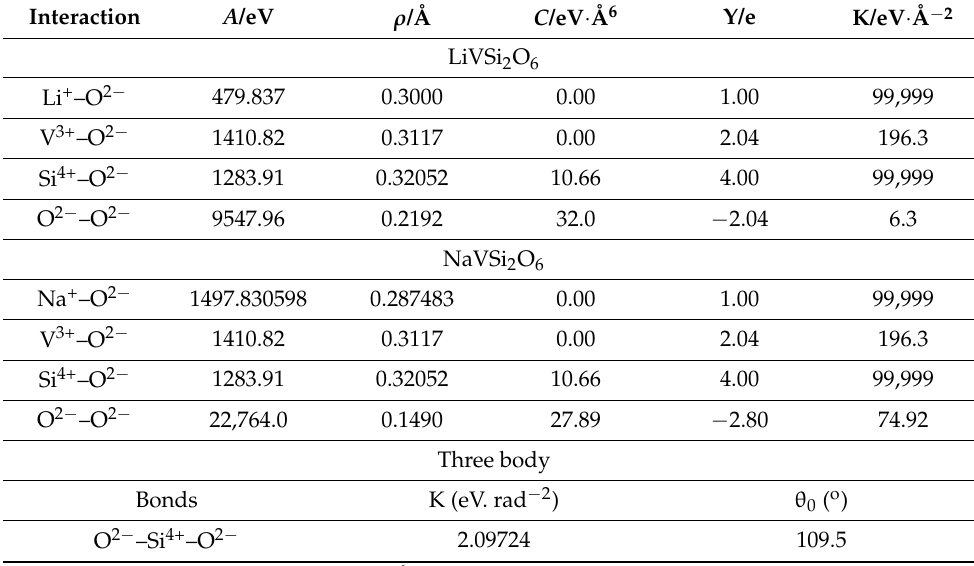
Table 1. Buckingham potential parameters used